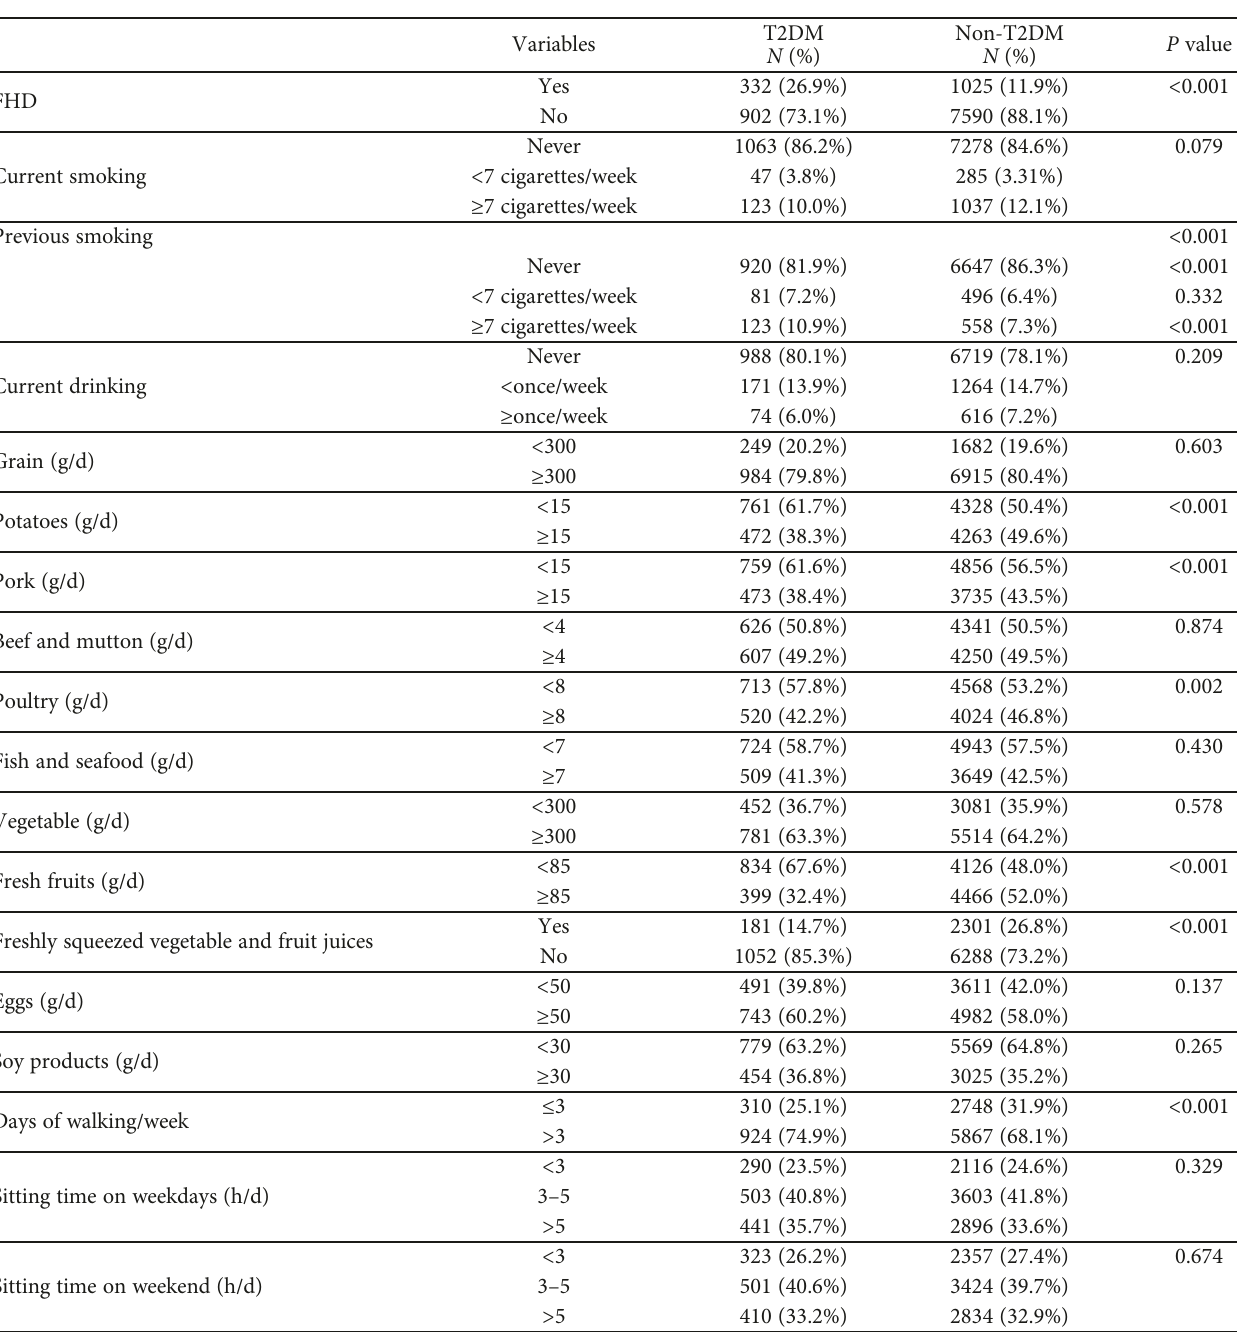
Table 2: FHD and lifestyle of the participants.